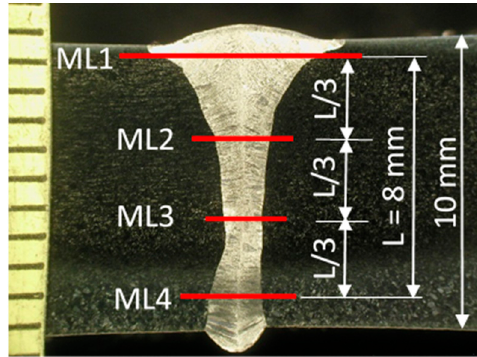
Figure 5. Example showing transversal EDS-measurement line locations (in red) ML1, ML2, ML3 and ML4 in the studied weld cross-sections.